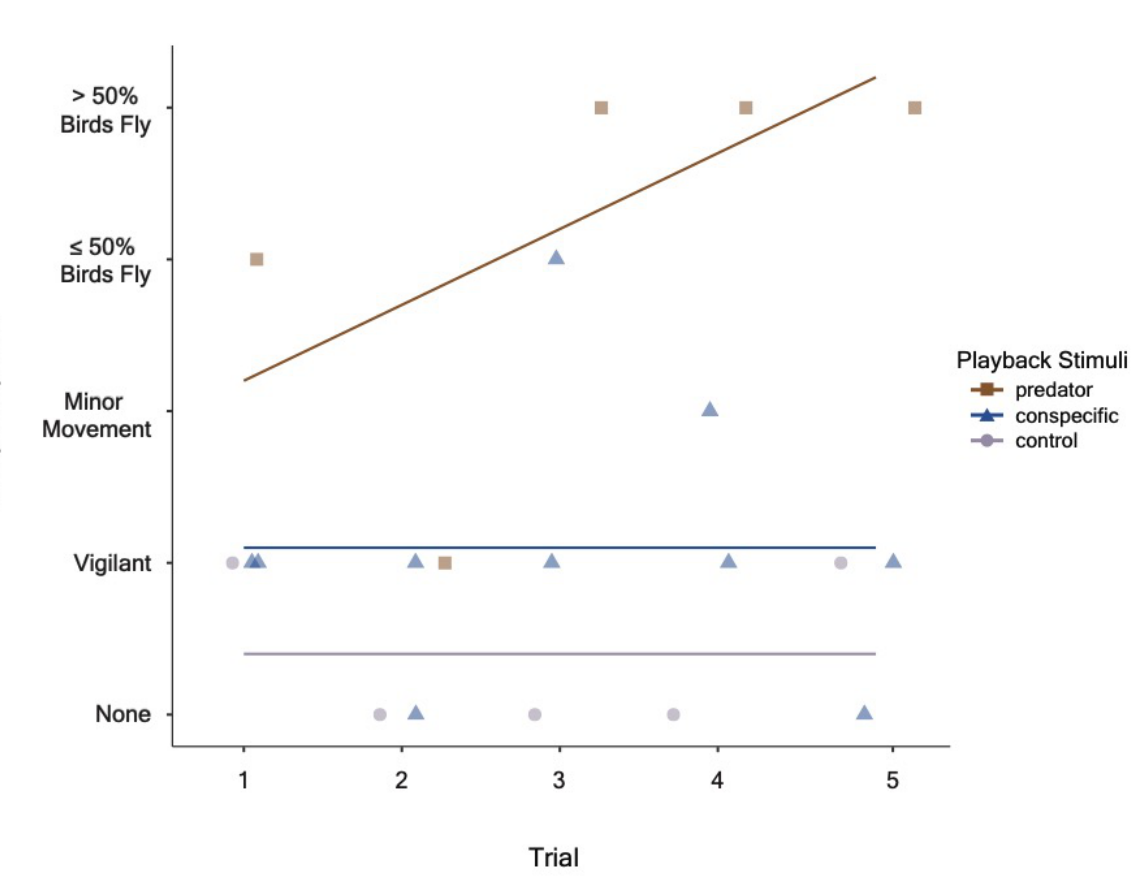
Group Responses to Playback Stimuli over the Test